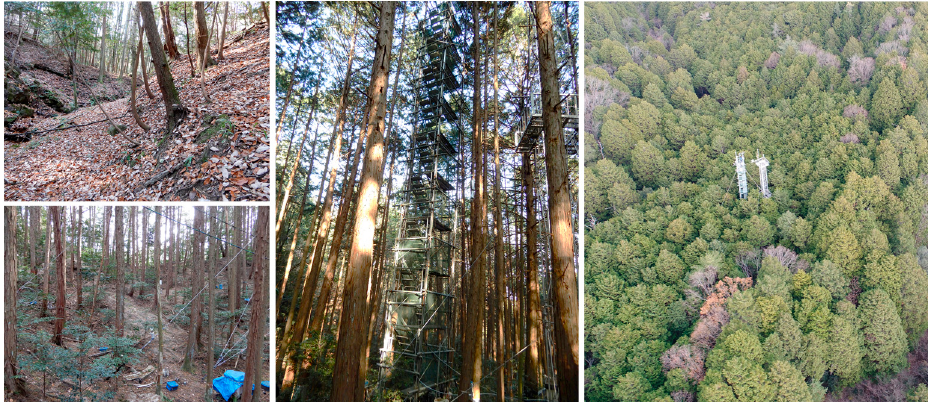
Figure 1. Characteristics of the Kiryu Experimental Watershed. Moderately dense trees are seen at the site with heterogeneous microtopography. The middle image shows the flux tower at the site from the surface, and the right image shows the flux tower and the surrounding landscape as seen from the unmanned aerial system (UAS) (Photo by author: 19 December, 2017). Detail of geographical location is shown by Iizuka et al. [34].